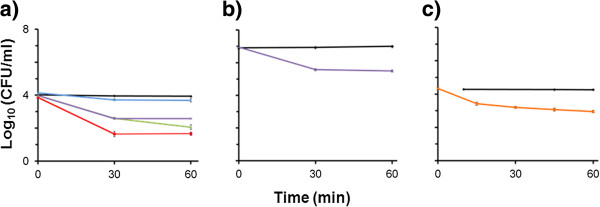
λSa2 and LysA exolytic activity in mock fermentations of corn fiber hydrolysates inoculated with L. fermentum and L. reuteri. a) Hydrolysate inoculated with 1x104 CFU/ml L. fermentum isolate BR0315–1 and treated with λSa2 endolysin at 250 ng/μl (red), 75 ng/μl (green), 25 ng/μl (purple) and LysA at 25 ng/μl (blue), PBS buffer control (black). b) Hydrolysate inoculated with 1x107 CFU/ml L. fermentum isolate BR0315-1 and treated with 25 ng/μl (purple) λSa2 endolysin, PBS buffer control (black). c) Hydrolysate inoculated with 1x104 CFU/ml L. reuteri strain B-14171 and treated with LysA at 760 ng/μl (orange), PBS buffer control (black). Data represent the average of four plate counts (n=4) ± SEM.